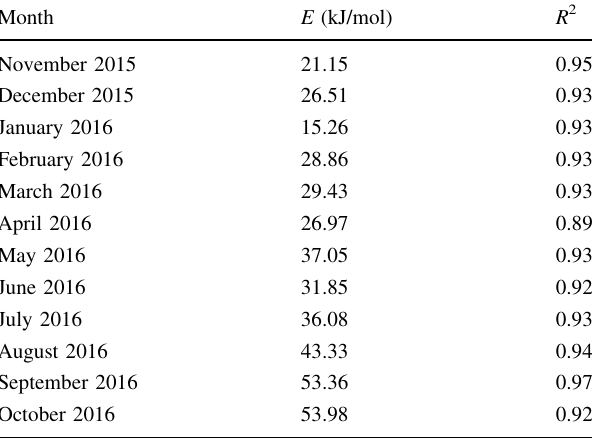
Table 3 Activation energies of coal samples obtained from Arrhe- nius parameter Month E (kJ/mol) R